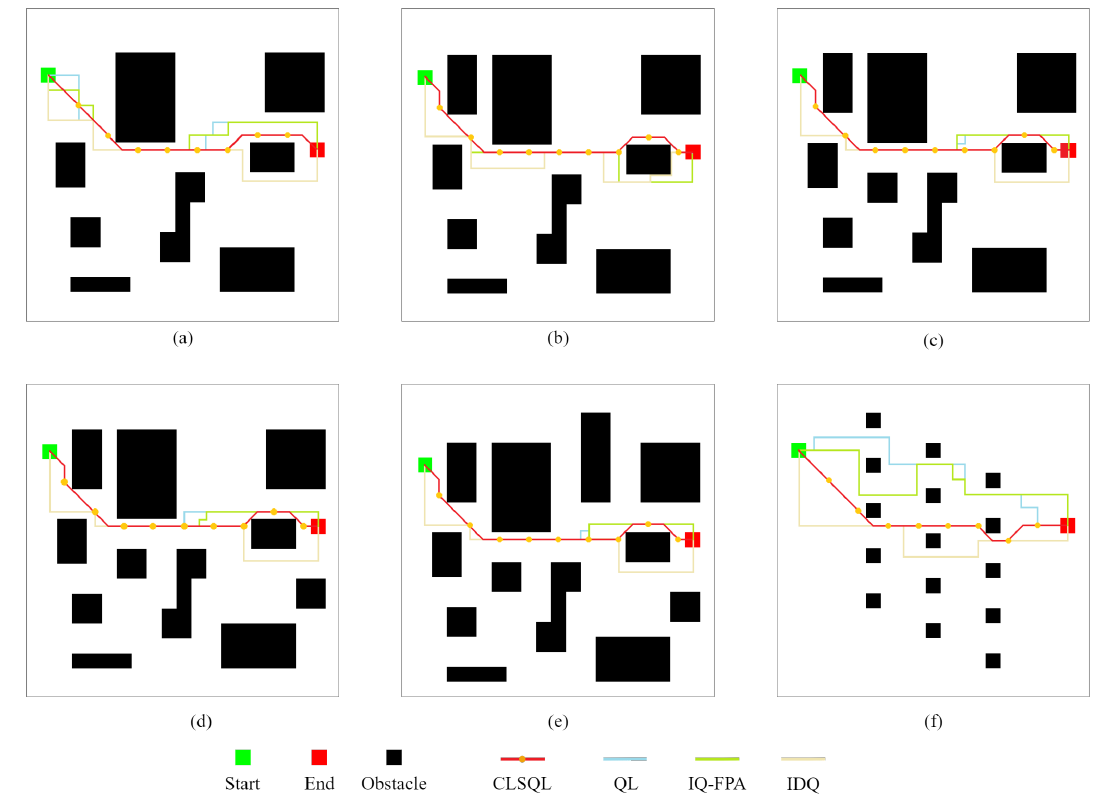
Figure 8. Experimental comparison of path results. ( a – f ) are the obtained path by different algorithms in T1-T6. Table 2. Performance Comparison of Map